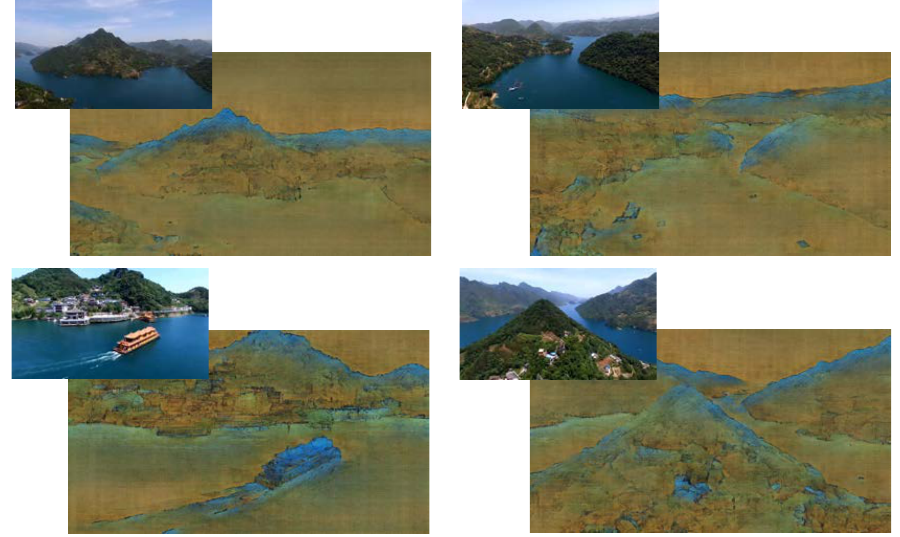
Figure 10. Transforming an aerial photograph into the Chinese painting style video. For the whole video, please see the additional